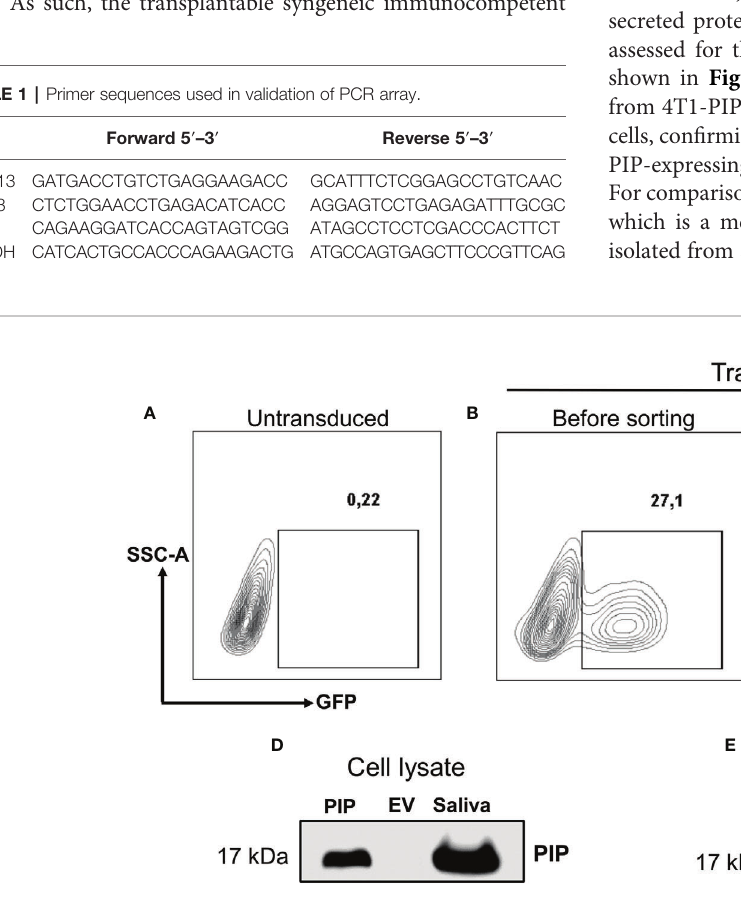
FIGURE 1 | Generation and con fi rmation of PIP-expressing 4T1 cells. Lentivirus encoding the mouse PIP cDNA – eGFP construct was incubated with 4T1 cells for overnight incubation. Contour plots show the percentages of GFP expressing 4T1 cells for un-transduced cells (A) and transduced cells before (B) and after sorting (C) by fl ow cytometry. Western blot analysis using polyclonal rabbit anti-mouse PIP antibody was performed on 4T1 cell lysate (D) and cell culture media (E) as described in the Materials and Methods section. Mouse saliva was used as a positive control for